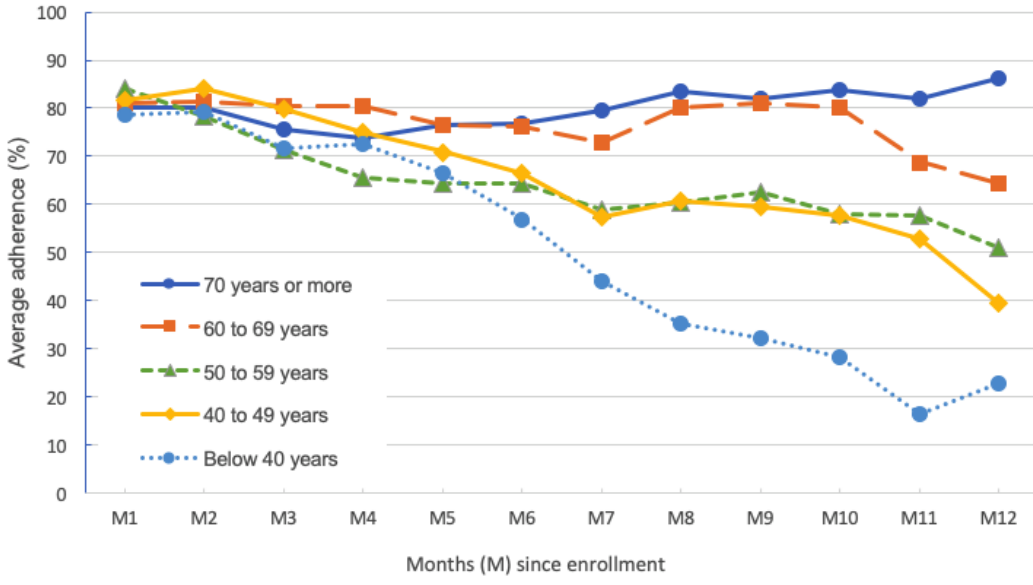
Figure 3. Average adherence rates over time by age group showing higher adherence over time for older age